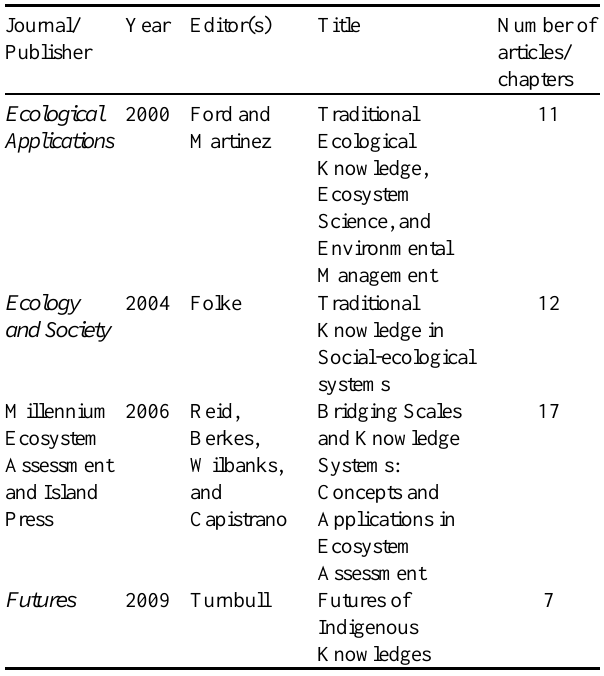
Table 1. Contents of literature